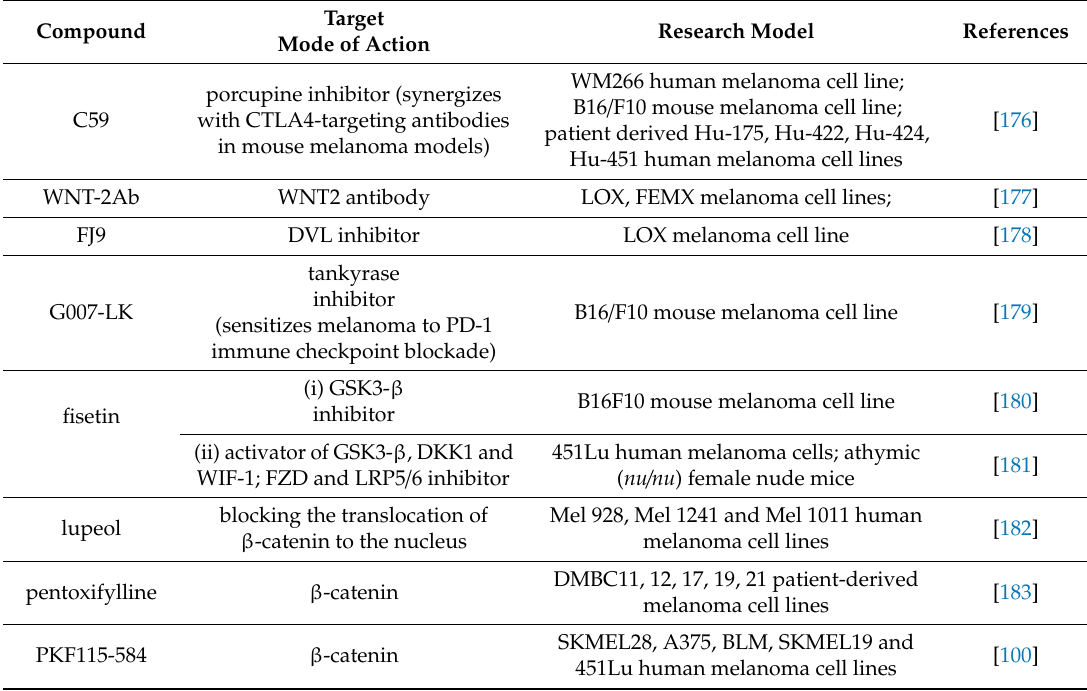
Table 2. WNT / β -catenin pathway inhibitors in melanoma (preclinical study).